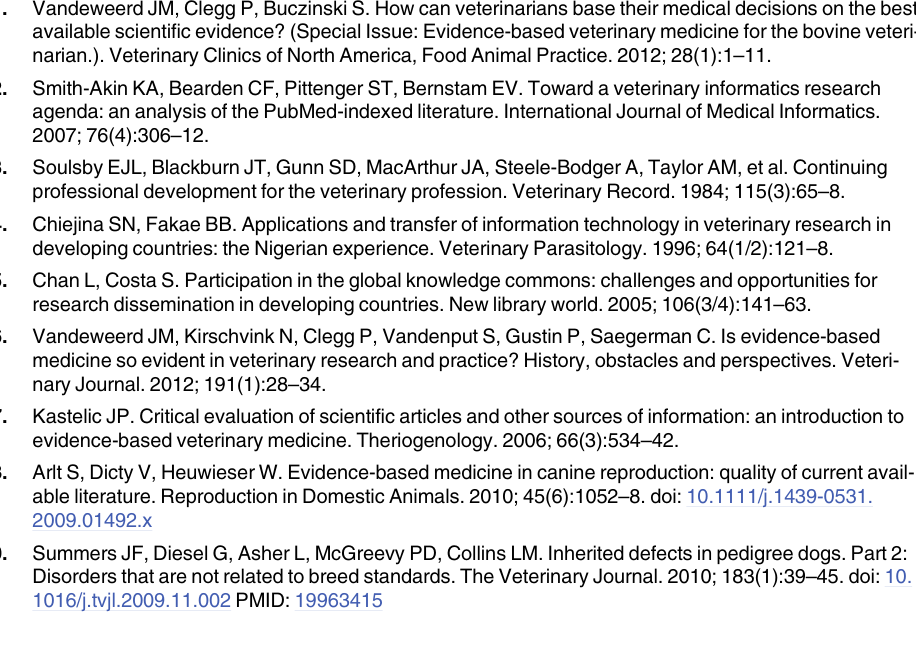
S1 Table. The top ten ranked journal resources nominated as the most useful by respon- dents (n = 1159). Only journals with more than 1 respondent nominating them have been listed. S2 Table. Top ten journals nominated as the most useful by clinicians and non-clinicians (n = 1159). Only journals with more than 1 respondent nominating them have been listed. S3 Table. The top ten electronic resources nominated as the most useful by respondents (n = 1117). Only electronic resources with more than 1 respondent nominating them have been listed. S4 Table. Top ten electronic resources nominated as the most useful by clinicians and non- clinicians (n = 1117). Only electronic resources with more than 1 respondent nominating them have been